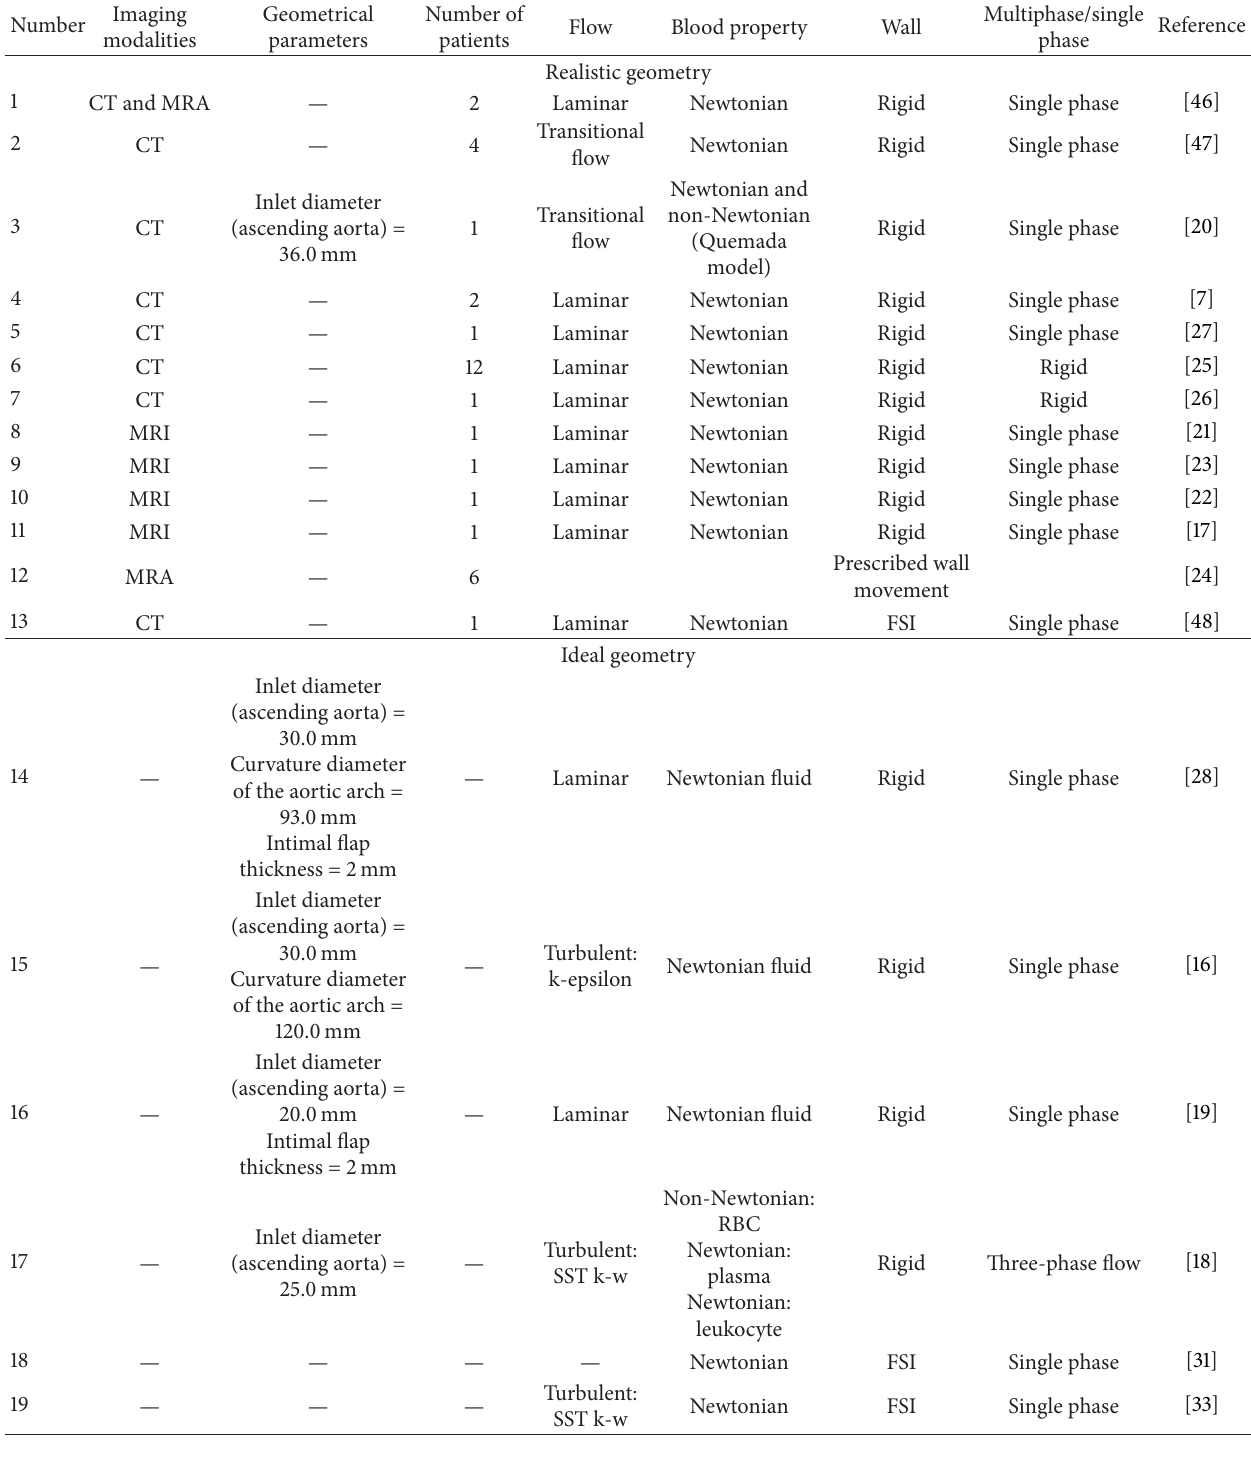
Table 1: Summary of the numerical simulation settings for aortic